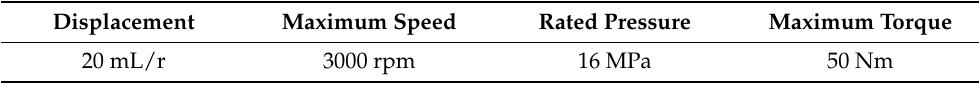
Table 2. Primary technical parameters of the internal gear